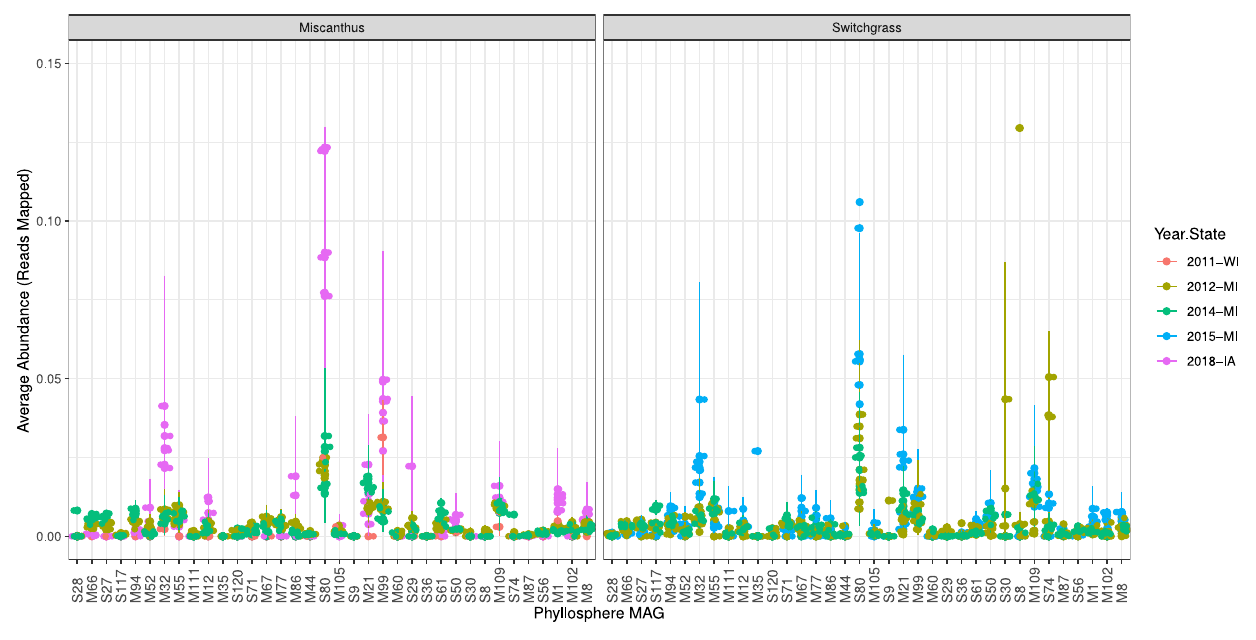
Fig. 8 | Detection of 36 focal MAGs (out of 40) in publicly available metagen- omes of bioenergy grasses based on the average number of reads mapped to each MAG. The sample size was 55 public metagenomes. Data are presented as